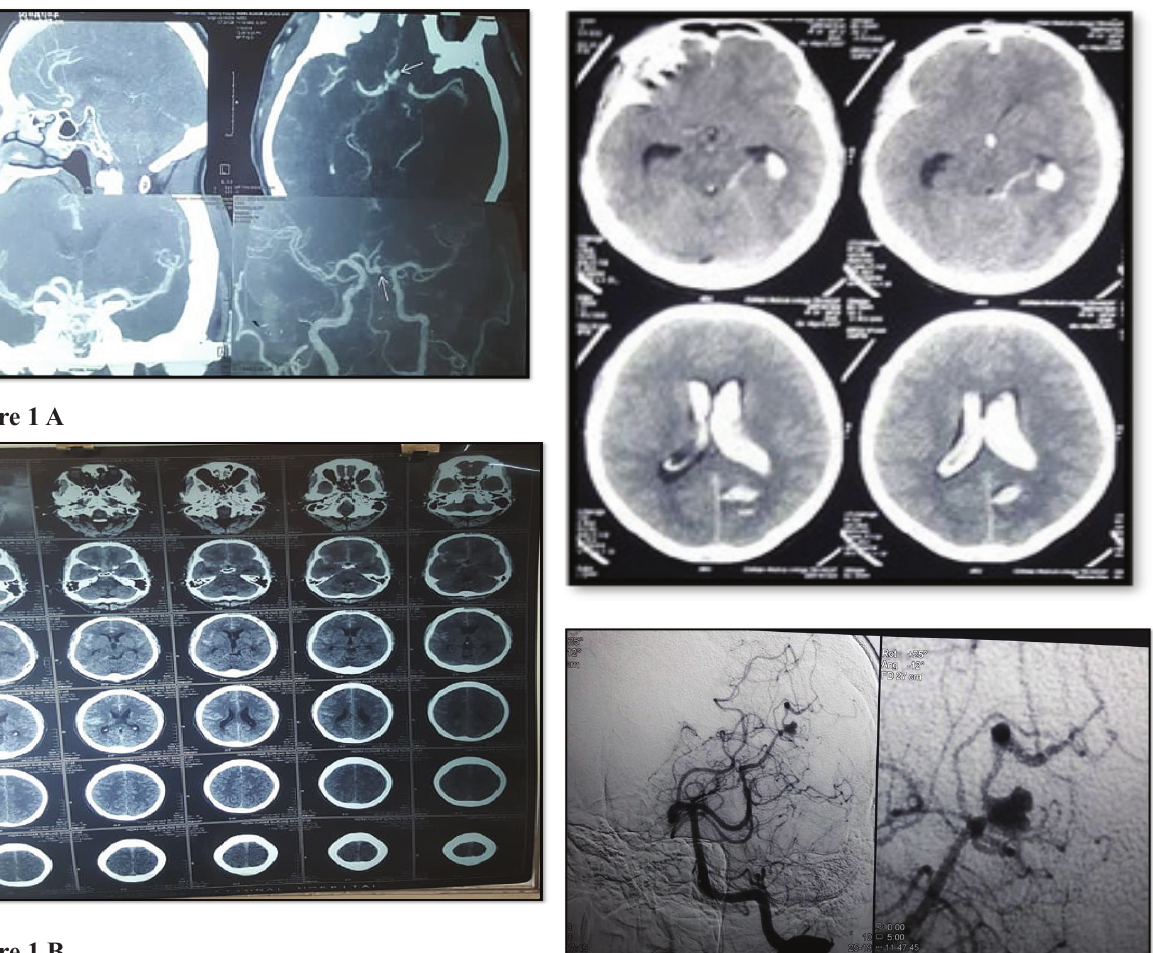
Figure.2 28 years/male presented with severe